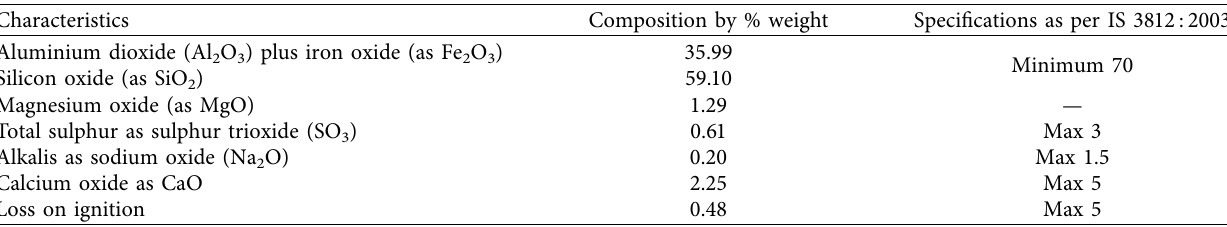
Figure 2: Constituents of geopolymer ferrocement. (a) Fly ash. (b) Sodium hydroxide. (c) Sodium silicate. (d) Wire mesh. (e) Steel fiber. (f) River sand. Table 2: Chemical compositions of low calcium fly